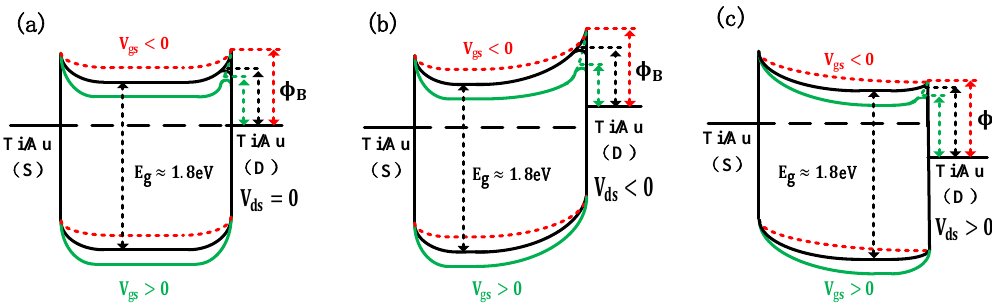
Figure 4. The energy band diagram at different gate voltage where V gs < 0 (red), V gs = 0 (black), V gs > 0 (green). ( a ) V ds = 0 (zero bias). ( b ) V ds < 0 (reverse bias). ( c ) V ds > 0 (positive bias). We find it that both V gs and V ds have an effort on the Schottky barrier heights. The Schottky barrier heights reduction is the most obvious when V gs > 0 and V ds < 0 (figure b green line).